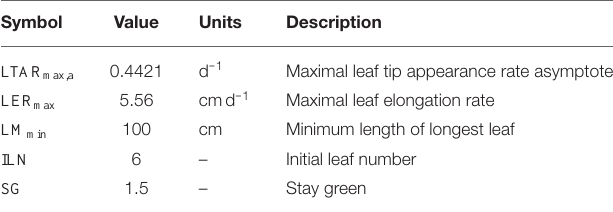
TABLE 2 | Parameters for cold stress response. TABLE 3 | Parameters for leaf development of Namdo (ND)